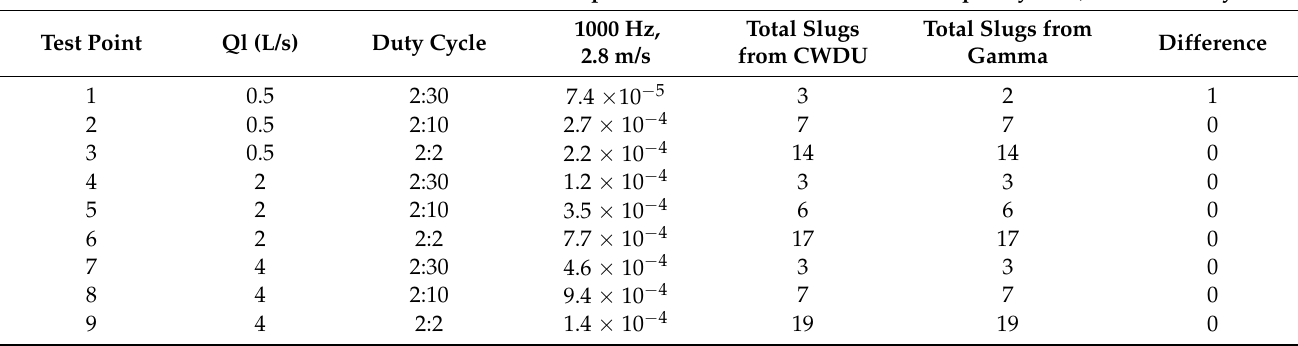
Table 3. Comparison of the number of slugs observed from CWDU using the bandpass power spectral density (BPSD) method and that from gamma measurement.